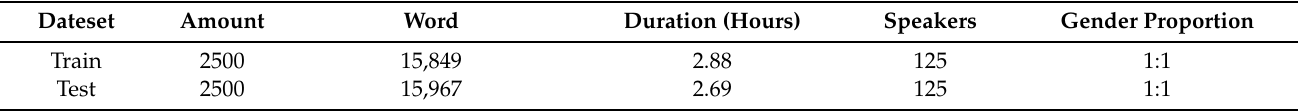
Table 5. Distribution of the data on